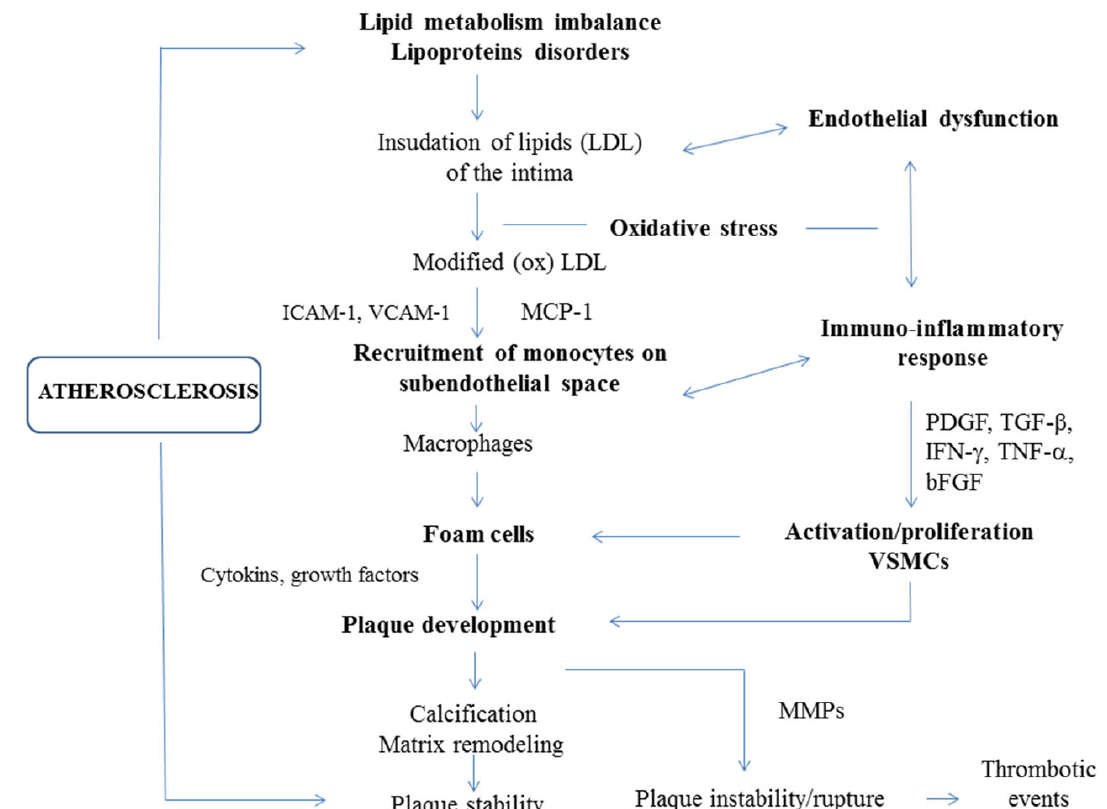
Figure 1. The pathogenesis of atherosclerosis. Atherogenesis is linked to both lipid metabolism and immune-inflammatory pathways. The process which leads to the formation of atherosclerotic plaques is complex and involves multiple steps. Endothelial dysfunction—induced by various noxious stimuli, including cardiovascular risk factors, disturbed hemodynamics and/or high levels of circulating lipids, particularly LDL—is a key component in the onset of atherosclerosis. Subendothelial accumulation of LDL and its oxidative modification to oxLDL promotes endothelial injury and induces a complex picture of immuno-inflammatory responses, starting from monocyte recruitment and macrophage activation, which lead to foam-cell formation and atherosclerotic plaque development. Monocyte chemoattractant protein 1 (MCP-1) and adhesion molecules (vascular cell adhesion molecule-1 (VCAM-1) and intercellular adhesion molecule-1 (ICAM-1)) are mainly responsible for monocyte chemotaxis and adhesion. Atherogenic activation and pheno ‐ typic switching of vascular smooth muscle cells (VSMCs) induced by pro ‐ inflammatory signaling (interferon γ (IFN ‐γ ) and tumor necrosis factor α (TNF ‐α )) and growth factors (platelet ‐ derived growth factor (PDGF), transforming growth factor β (TGF ‐β ) and basic fibroblastic growth factor (bFGF)) also contribute to foam cell and plaque formation. Calcification and extracellular matrix remodeling may stabilize atherosclerotic plaques. Macrophages and foam cells release matrix